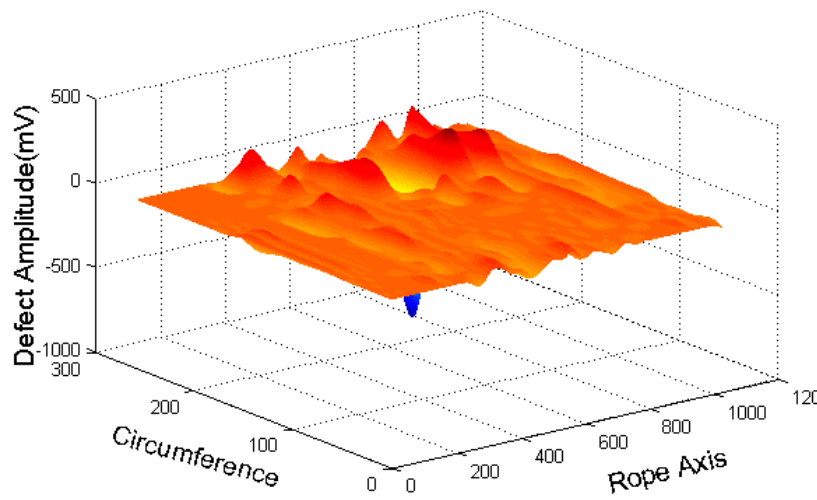
Figure 7. Three-dimensional diagram interpolated data.